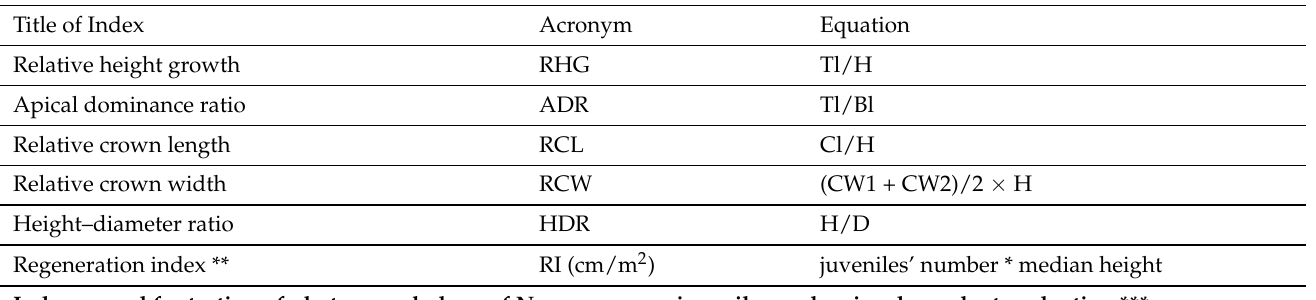
Table 4. Photo-morphological indexes calculated for Norway spruce juveniles considered within two different approaches of data